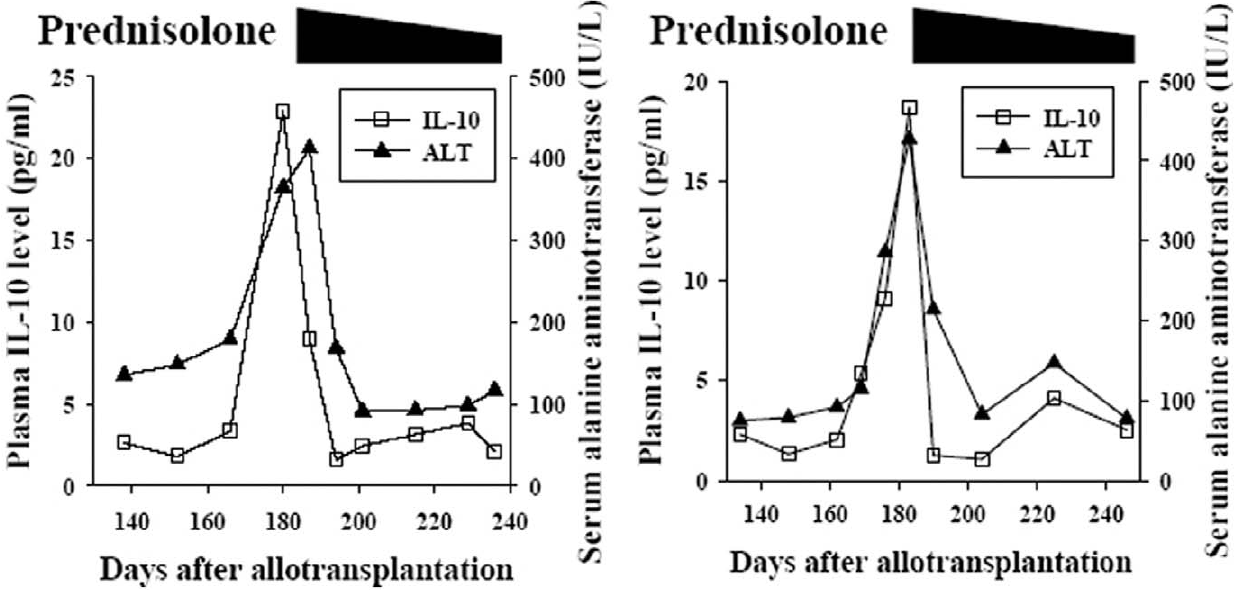
Figure 4. Prompt response of plasma IL-10 to effective immunosuppressive therapy in 2 patients with hepatic GVHD (4A: Patient No. 15; 4B: Patient No. 16). Plasma IL-10 increases in two patients with pathologically documented hepatic GVHD. After prednisolone treatment, the decrease of plasma IL-10 is prompt and earlier than clinical improvement of hepatic function.